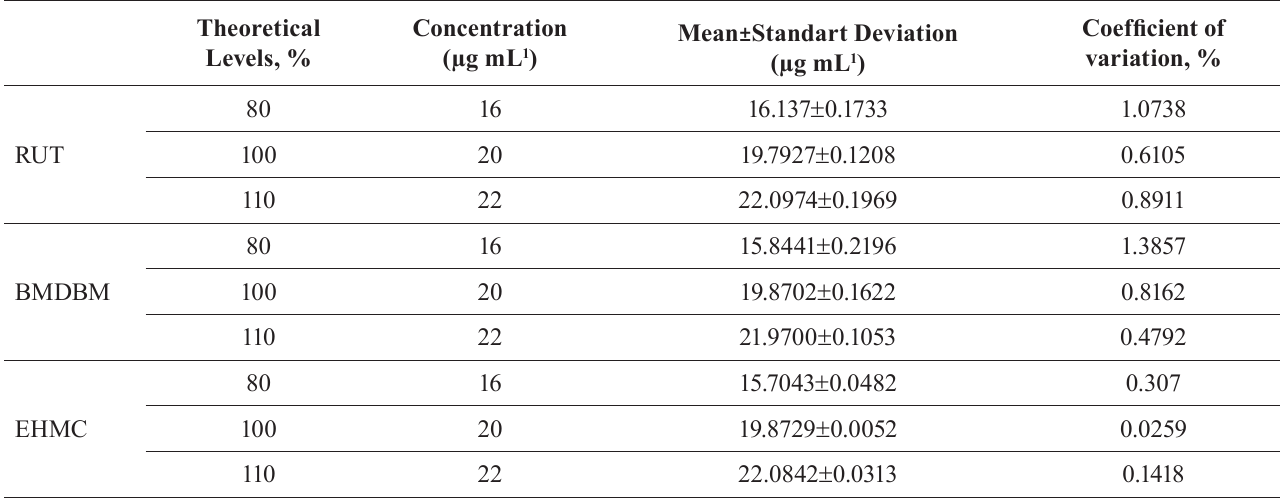
TABLE IV - Mean, standard deviation, and coefficient of variation obtained for rutin, BMDBM, and EHMC in the precision study